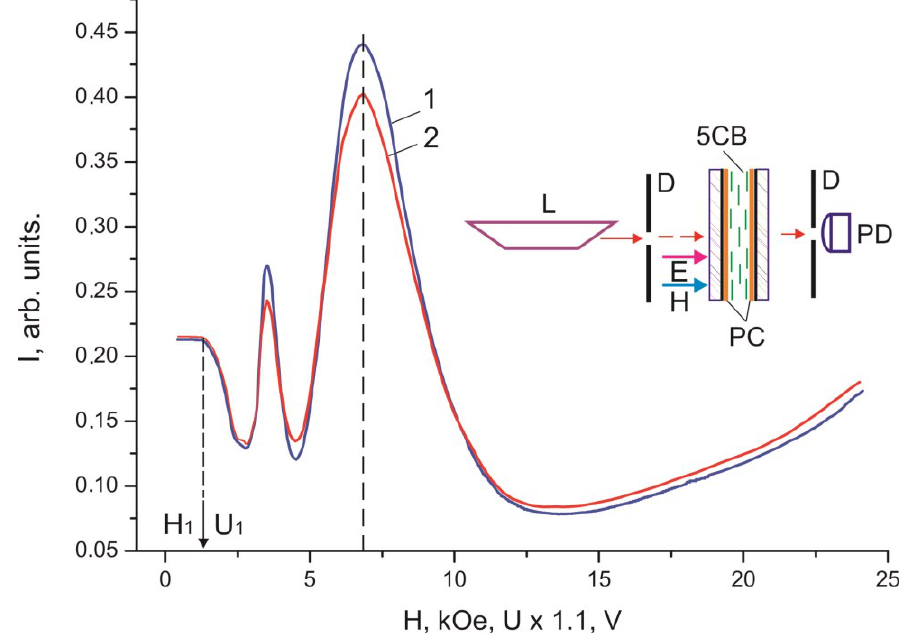
Figure 5. Dependences of intensity I of monochromatic light passed through the 30 µm thick planar 5CB layer formed in magnetic field H * on magnetic field H (curve 1) and voltage U (curve